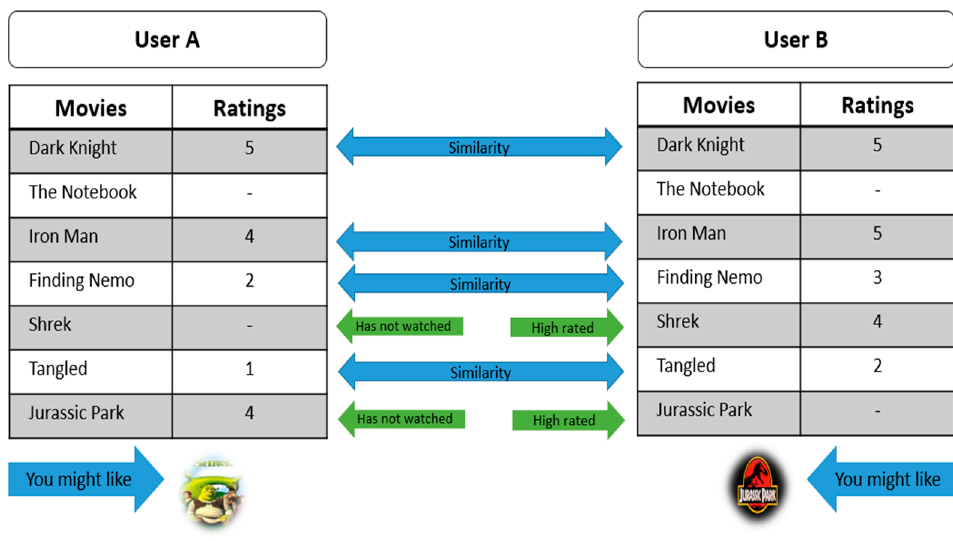
Figure 2. Basic structure of collaborative filtering.